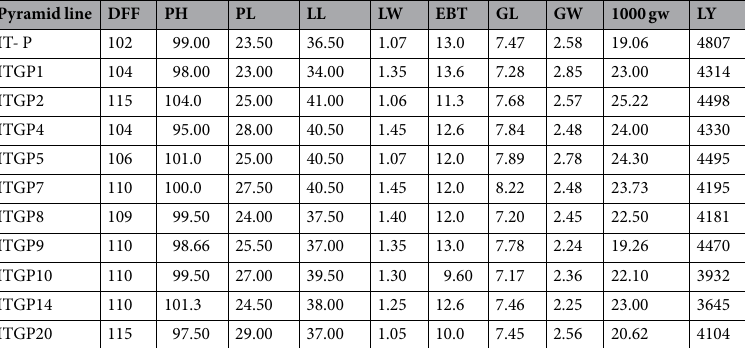
Table 3. Morpho-agronomic characteristics of selected gene pyramids. DFF- Days to fifty percent flowering; PH-Plant height; PL- Panicle length; LL- Leaf length; LW- Leaf width; EBT- Ear bearing tillers; GL-Grain length; GW- Grain width; % Fertility-Fertile spikelets/total spikelets (%); 1000 gw-grain weight of 1000 grains (gms); LY-Line yield